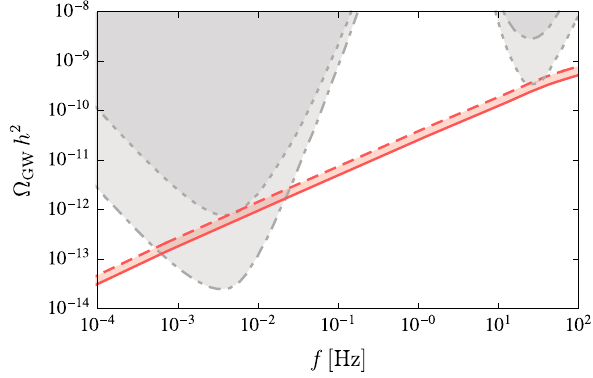
Fig. 1 The stochastic gravitational-wave spectrum Eq. (13) for the spectator-field model of Ref. [16], using exemplary μ = 12 M (cid:10) , v = 20km / s, and f = 1. The red dashed curve shows the result vir PBH including spin, while the red solid curves depicts the (hypothetical) case in which the effect of spin has been neglected. The two dotted and dot-dashed grey curves at on the low-frequency side represent the expected sensitivities for LISA for the worst and best experimental designs, respectively [47]. Also shown, on the high-frequency side, are the limits from the O2 (dotted) and O5 run (dot-dashed, forecast) of Advanced LIGO cf. Fig. 3 of Ref.